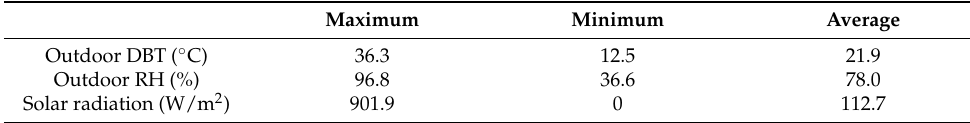
Table 2. Environmental parameters during the